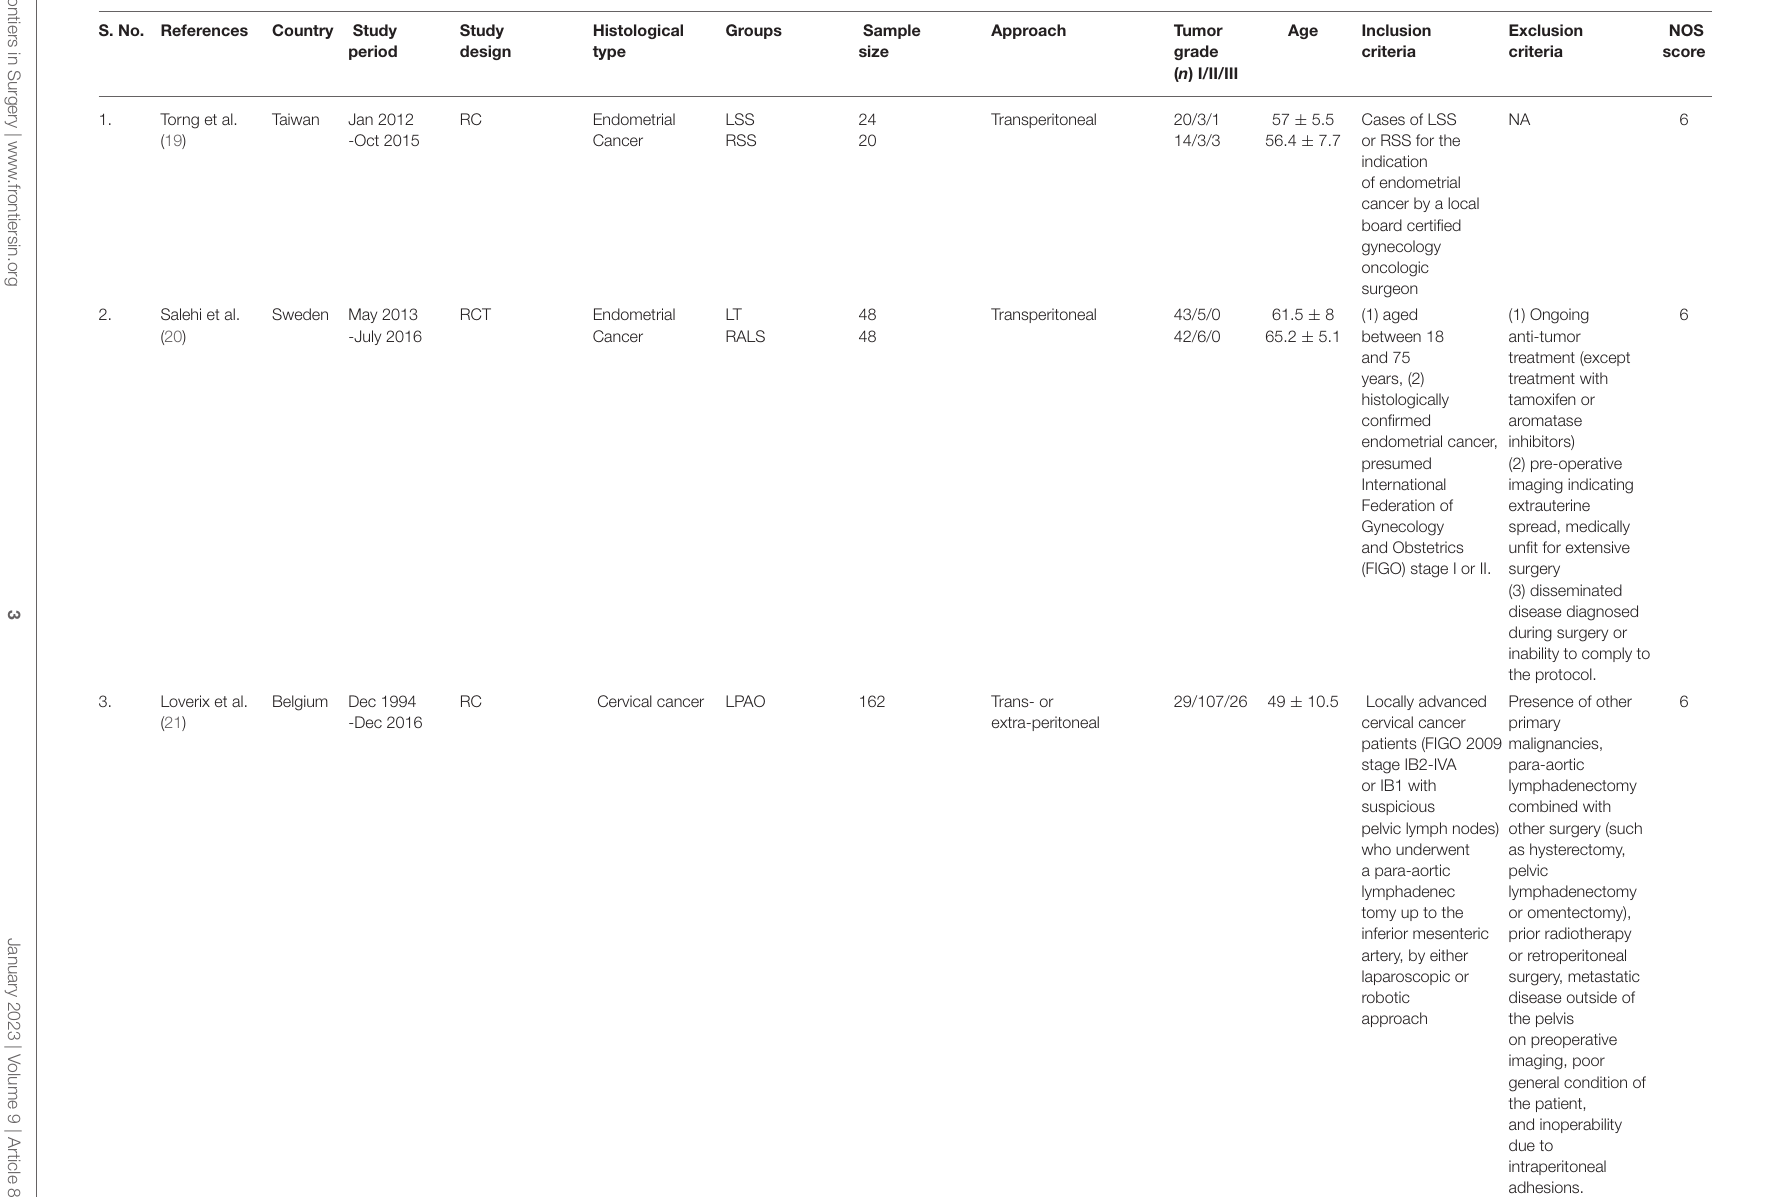
TABLE 1 | Characteristics of included studies for the comparison of robotic-assisted vs. conventional laparoscopy for para-aortic lymphadenectomy in gynecological